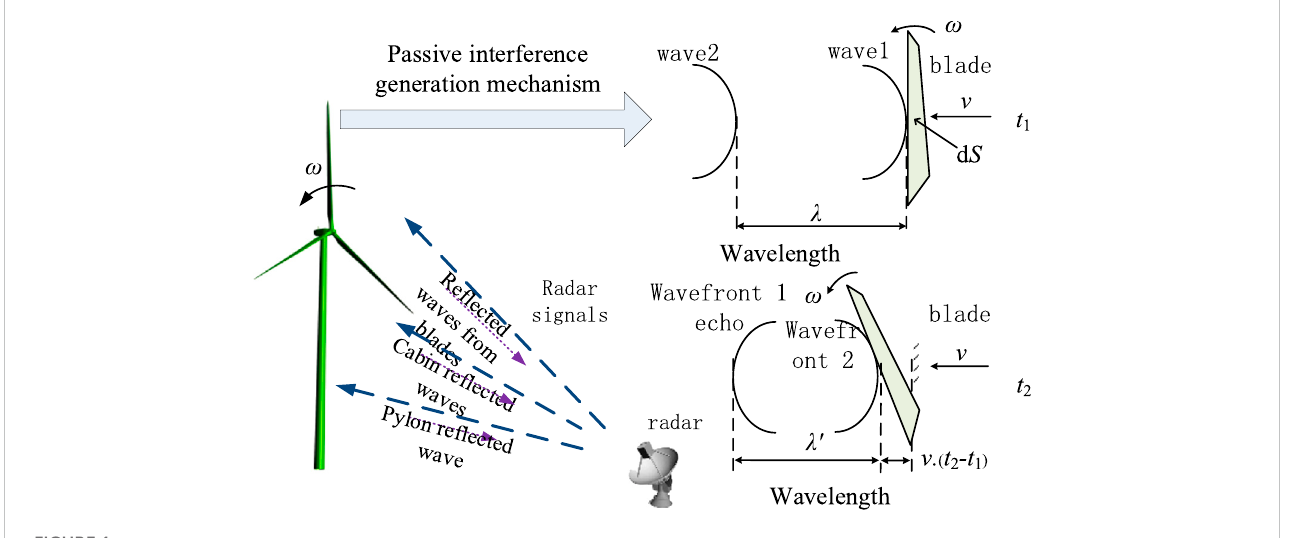
FIGURE 1 Schematic diagram of passive interference of WT to radar